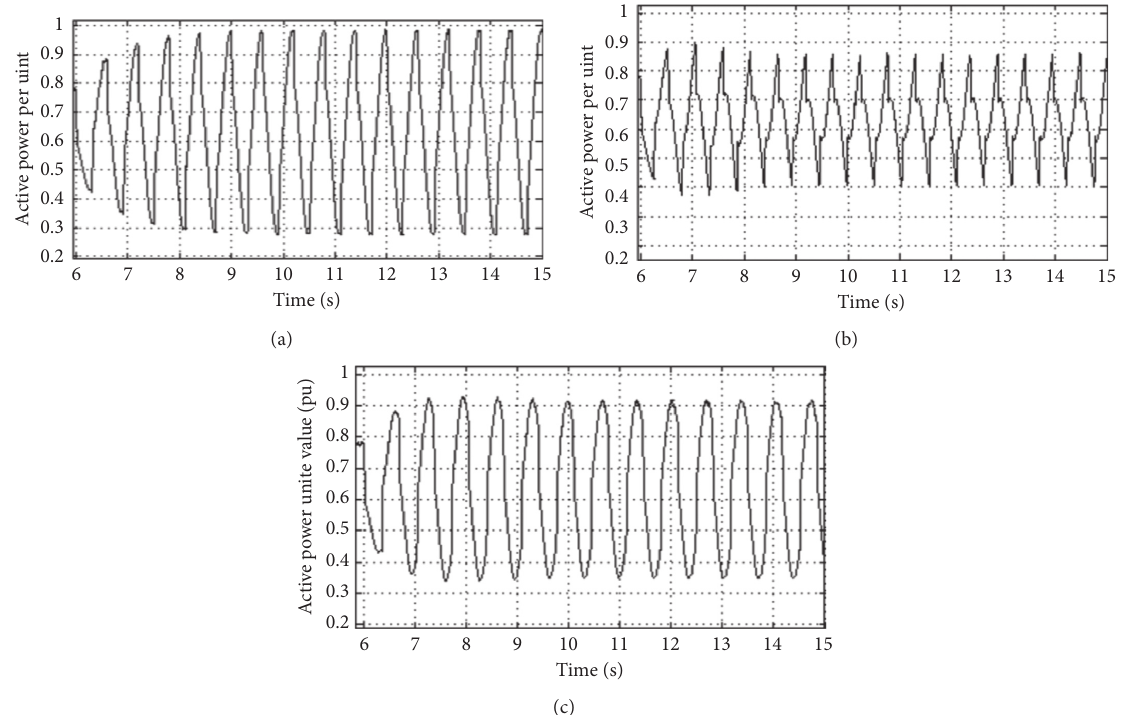
Figure 14: The active power oscillation curve of the line under different disturbance frequencies of (a) 1.67 Hz, (b) 1.87Hz, and (c) 1.47Hz.